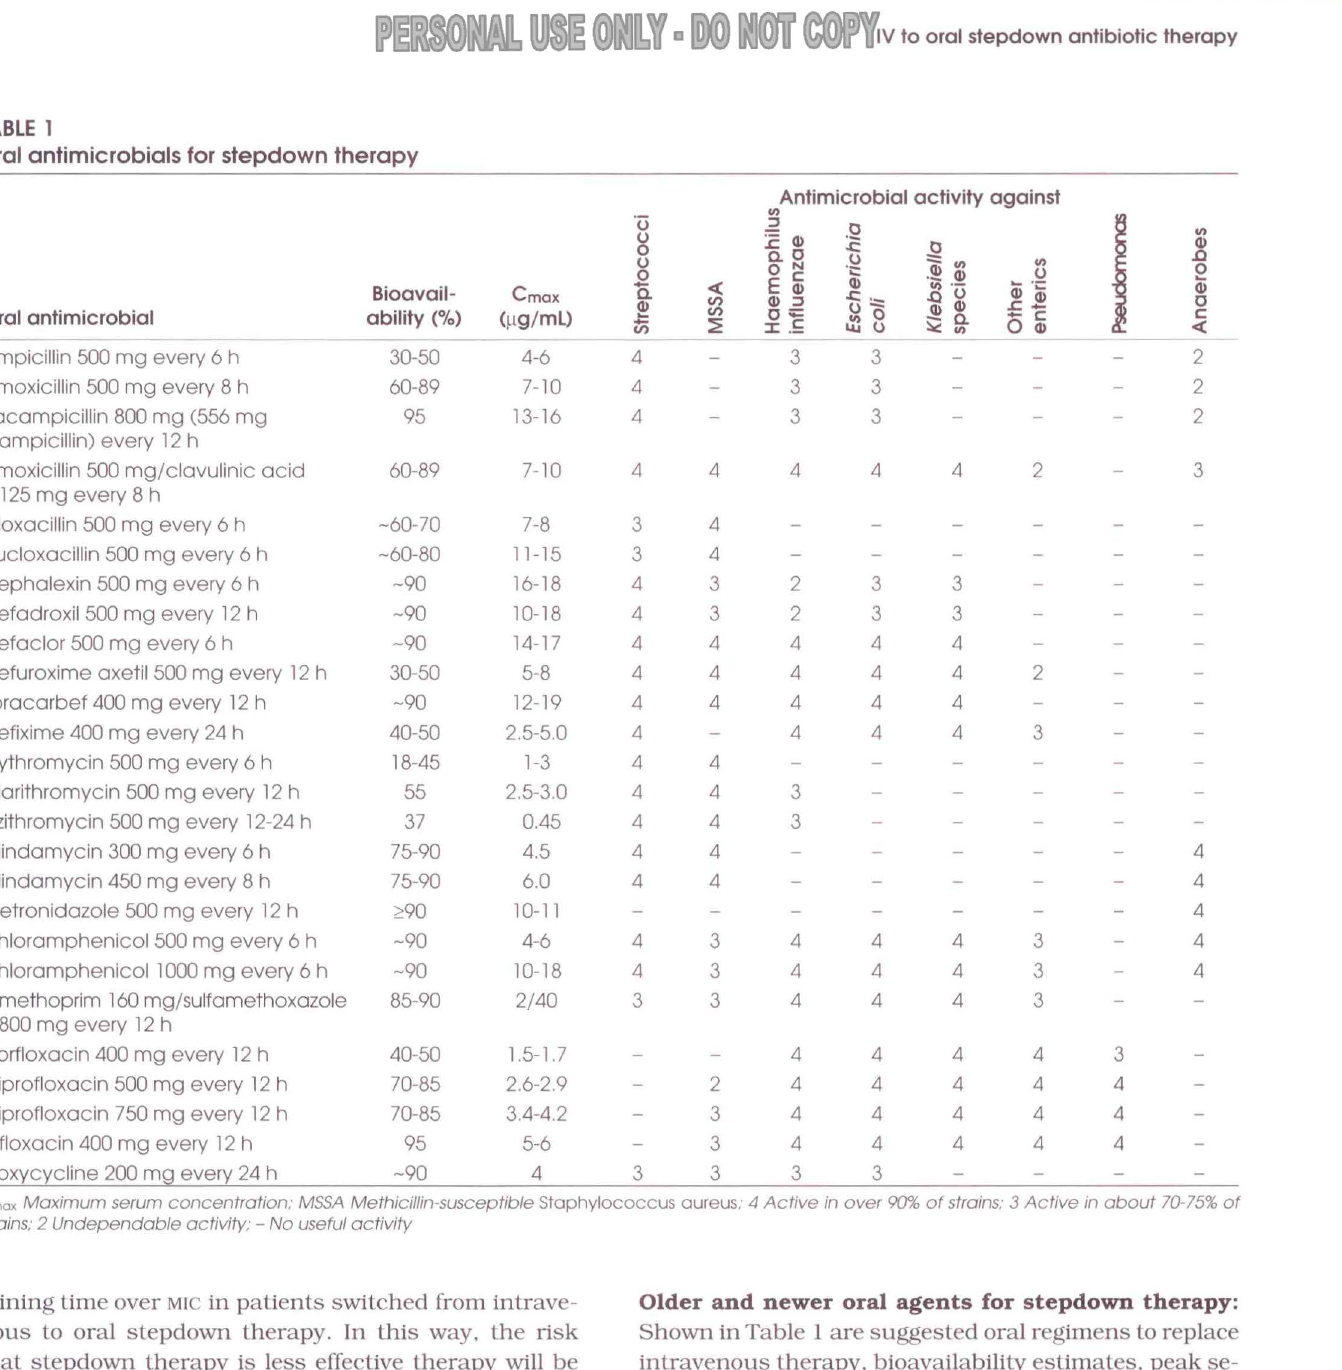
Y • DO IOT COPYiv to oral stepdown antibiotic therapy